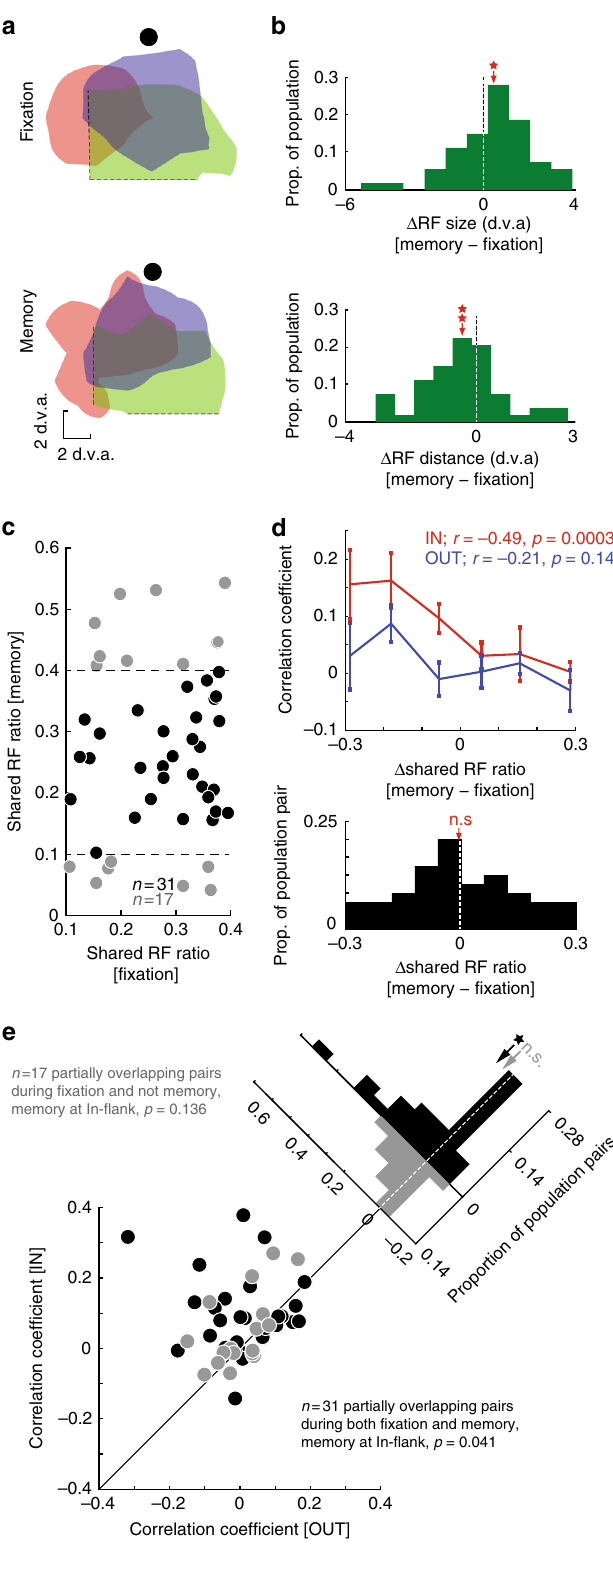
network in the combined presence of top – down and bottom – up input. A simple schematic illustration of such a scenario is pre- sented in Supplementary Figure 12. The fi nding that the maintenance of a spatial memory is suf- fi cient to decorrelate visual responses in extrastriate cortex is yet another similarity between the effects of spatial WM and covert attention (reviewed in Supplementary Discussion). Noise corre- n =17 partially overlapping pairs lations can dramatically affect the information content of a during fixation and not memory, neuronal population response 8, 11, 35 – 37 . These correlations are memory at In-flank, p = modulated by factors including attention 9, 10 , providing an additional means for attentional modulation to improve neuronal representations at the population level, and ultimately contribute to the perceptual bene fi ts of attention. Indeed, changes in noise correlations have been suggested to be a key player underlying attention-induced representational enhancement 9 . By identifying a dissociation between the effects of a top – down signal in isola- tion and in the presence of visual input, these results provide a crucial step towards understanding the interactions between top – down and bottom – up signals and how this interaction alters correlated variability in sensory areas. n =31 partially overlapping pairs during both fixation and memory, memory at In-flank, p = 0.041